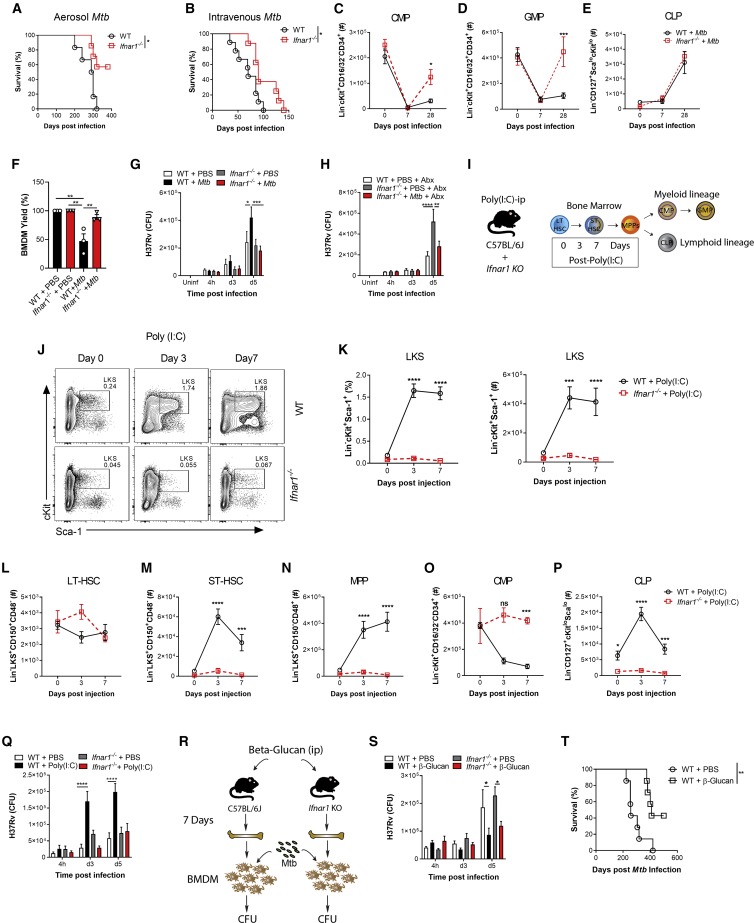
Mtb Suppresses Myelopoiesis and Impairs Innate Training in an IFN-I-Dependent Manner(A and B) Survival following (A) aerosol (n = 6–7 mice/group) or (B) i.v. (n = 8–9 mice/group) infection.(C–E) Total CMPs (C), GMPs (D), and CLPs (E) after i.v. infection.(F) Relative BMDM yield.(G) In vitro BMDM CFUs with Abx in culture.(H) In vitro BMDM CFUs with Abx in vivo.(I) Poly(I:C) model.(J and K) Representative FACS plots of LKS cells as quantified in (K) with percentages (left) and totals (right).(L–P) Total LT-HSCs (L), ST-HSCs (M), MPPs (N), CMPs (O), and CLPs (P).(Q) In vitro BMDM CFUs.(R) β-Glucan model.(S) In vitro BMDM CFUs (n = 6–7 replicates/group).(T) Aerosol survival (7 mice/group).In (A), (B), and (T), log rank test was used. In (C)–(E), (G), (H), (K)–(Q), and (S), two-way ANOVA followed by Sidak’s multiple comparisons test was used. In (F), one-way ANOVA followed by Tukey’s multiple comparisons test was used. Data are representative of two (S) or three (C–Q) independent experiments. See also Figure S4.